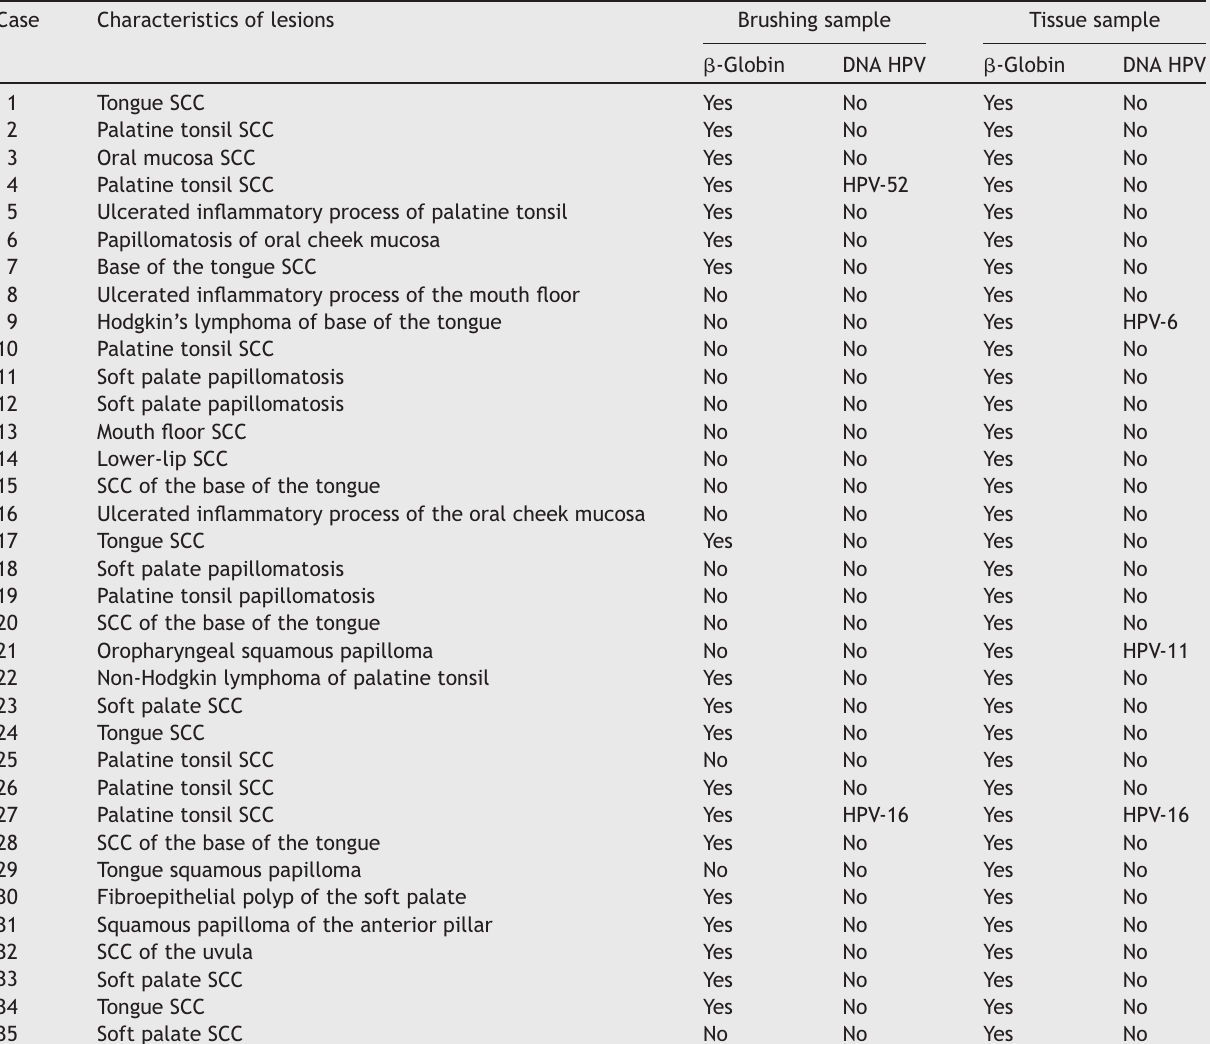
Table 1 Characteristics of the samples and results obtained by PCR of the (cid:2) -globin gene, viral DNA detection, genotyping by linear array hybridization of the material obtained by biopsy, and brushing sampling